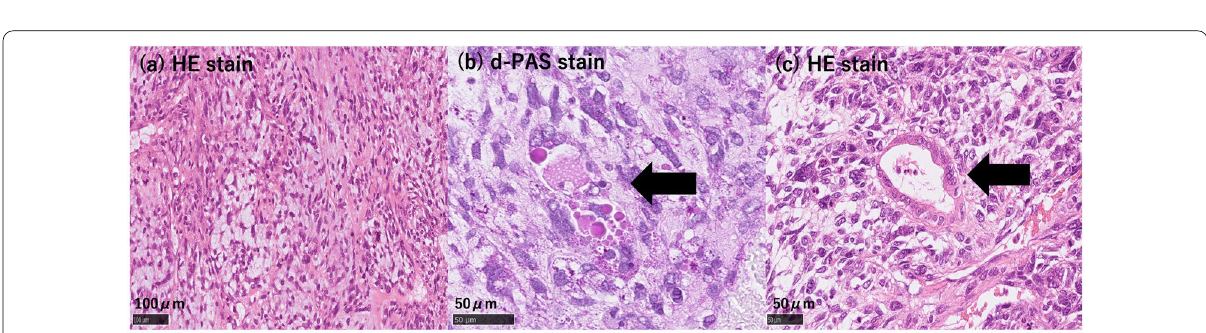
Fig. 4 a The tumor is composed of spindle-shaped cells ( d-PAS-positive